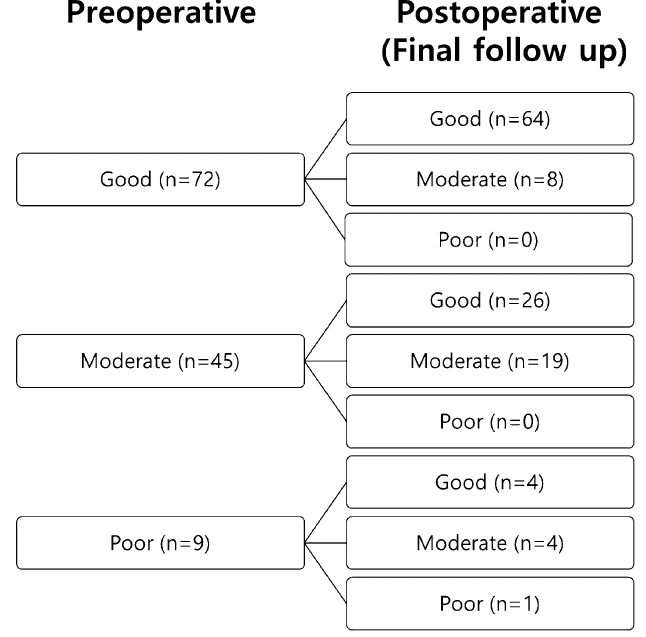
Figure 2. Postoperative changes in the Titmus stereotest results grouped by preoperative stereoacuity results in Group B.